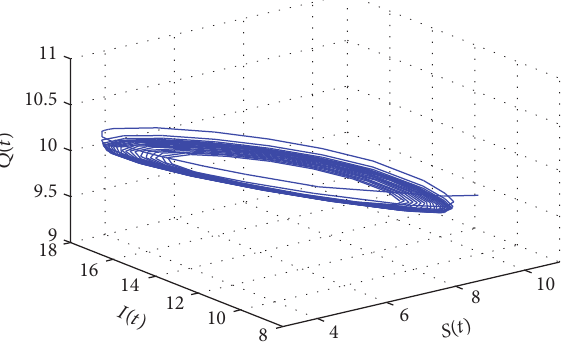
Figure 17: The phase plot of 𝑆 , 𝐼 , and 𝑄 when 𝜏 1 = 0.9755 > 0.8903 = 𝜏 󸀠 10 and 𝜏 2 = 1.05 .